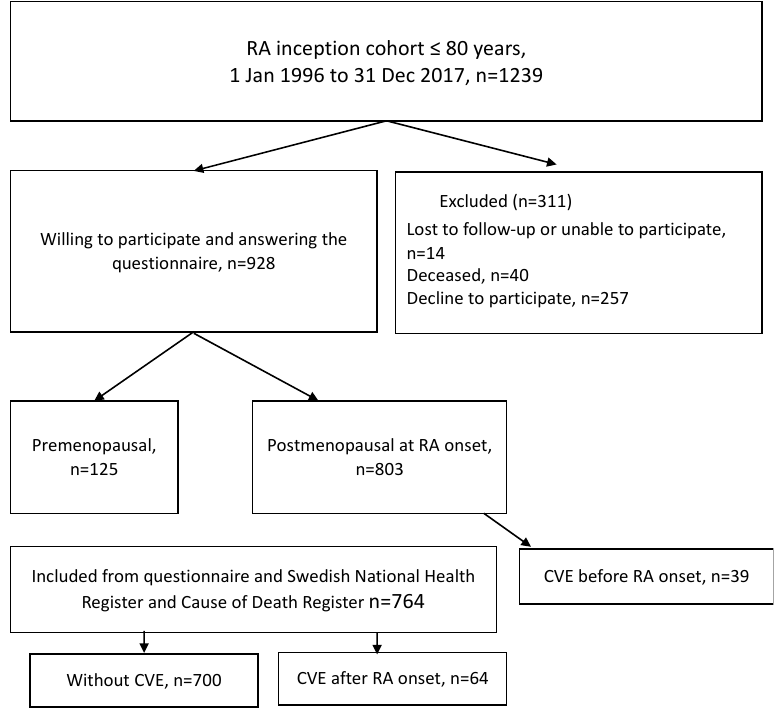
Figure 1. Flowchart illustrating the inception cohort of RA patients.